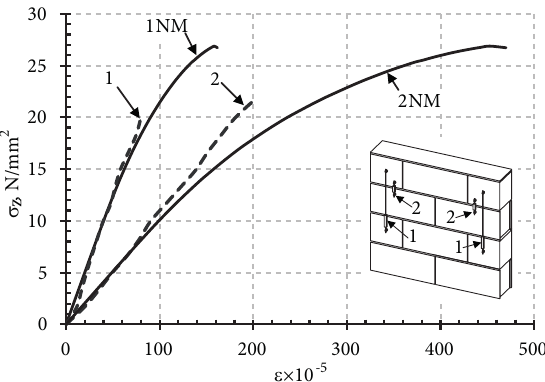
stresses and ε relative deformations: Fig. 12. Diagram of σ c c 1 and 1NM – of the masonry estimated by experiments and numerical modelling respectively; 2 and 2NM – of the bed joint zone estimated by experiments and numerical modelling